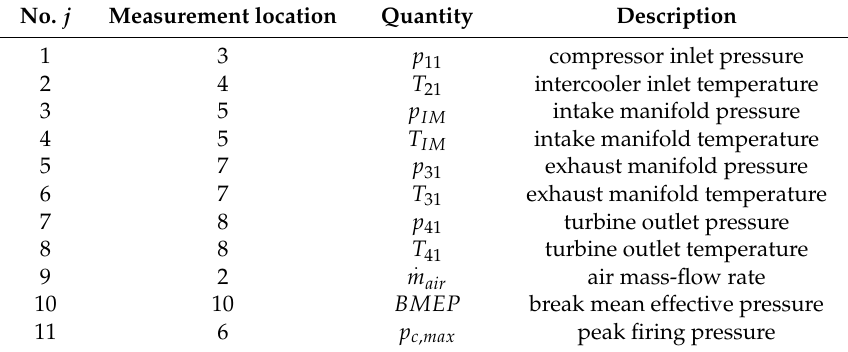
Table 2. Measurement data used for the merit function evaluation by calibration of the ICESM in Figure 1. No. j Measurement location Quantity Description 1 3 p 11 compressor inlet pressure intake manifold